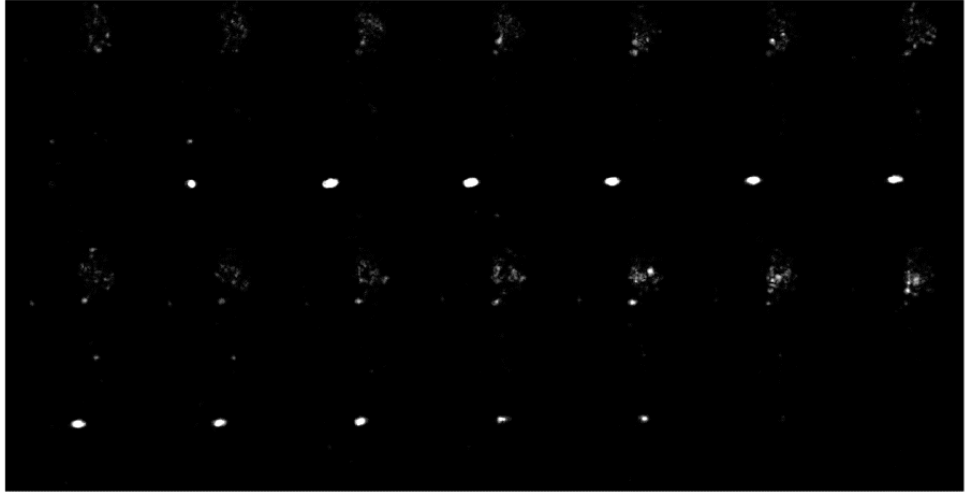
Figure 8. Sample frame subsequence displaying the optical flow determined velocity magnitudes mapped as normalized values between 0–255. Whiter shades represent larger velocity magnitudes, hence, more intense motion.